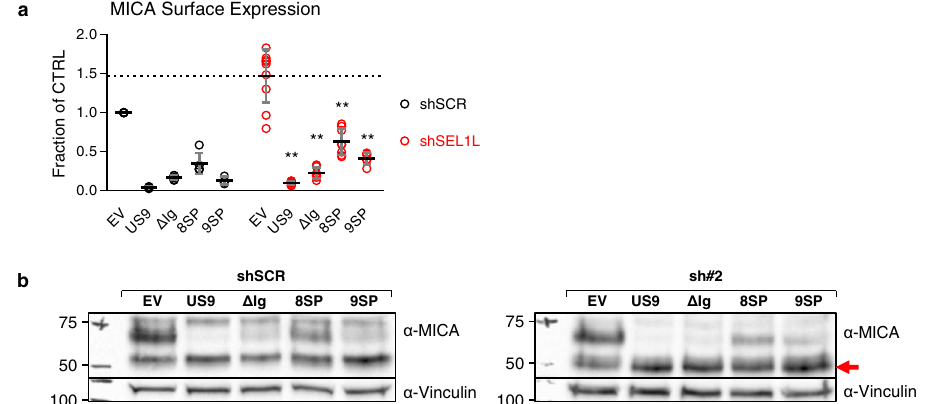
Fig. 8 US9 SP arrests MICA*008 maturation in SEL1L ’ s absence. RKO MICA*008-HA cells expressing shScrambled (shSCR) or shSEL1L#2 (sh#2) were co-transduced the indicated constructs. a Quanti fi cation of MICA*008 surface expression on the indicated cells measured by fl ow cytometry. MFIs were normalized to the MFI of shSCR EV transfectants. Data show mean ± SEM for at least three independent experiments per construct. A two-way ANOVA (knockdown, US9 construct expression) was conducted to compare the normalized MFIs of the various constructs in shSCR vs. shSEL1L cells. The main effect of knockdown was signi fi cant at the p < 0.05 level [F(1,56) = 41.46, p = 2.01 × 10 − 8 ]. The main effect of US9 construct expression was also signi fi cant [F(4,56) = 276.73, p = 3.59 × 10 − 36 ]. There was a signi fi cant interaction between knockdown and US9 construct expression [F(4,56) = 20.16, p = 2.5 × 10 − 10 ]. A post hoc Tukey test was used to compare EV MFI (dashed line) to that of each construct in the shSEL1L-expressing cells. ** p < 0.01. b Lysates were obtained from the indicated cells and blotted using anti-MICA and anti-vinculin loading control. The red arrow indicates glycosylation- trimmed MICA*008. Representative of two independent repeats. See also Figs. S7 – 8 and the Source Data fi le for experimental data and full